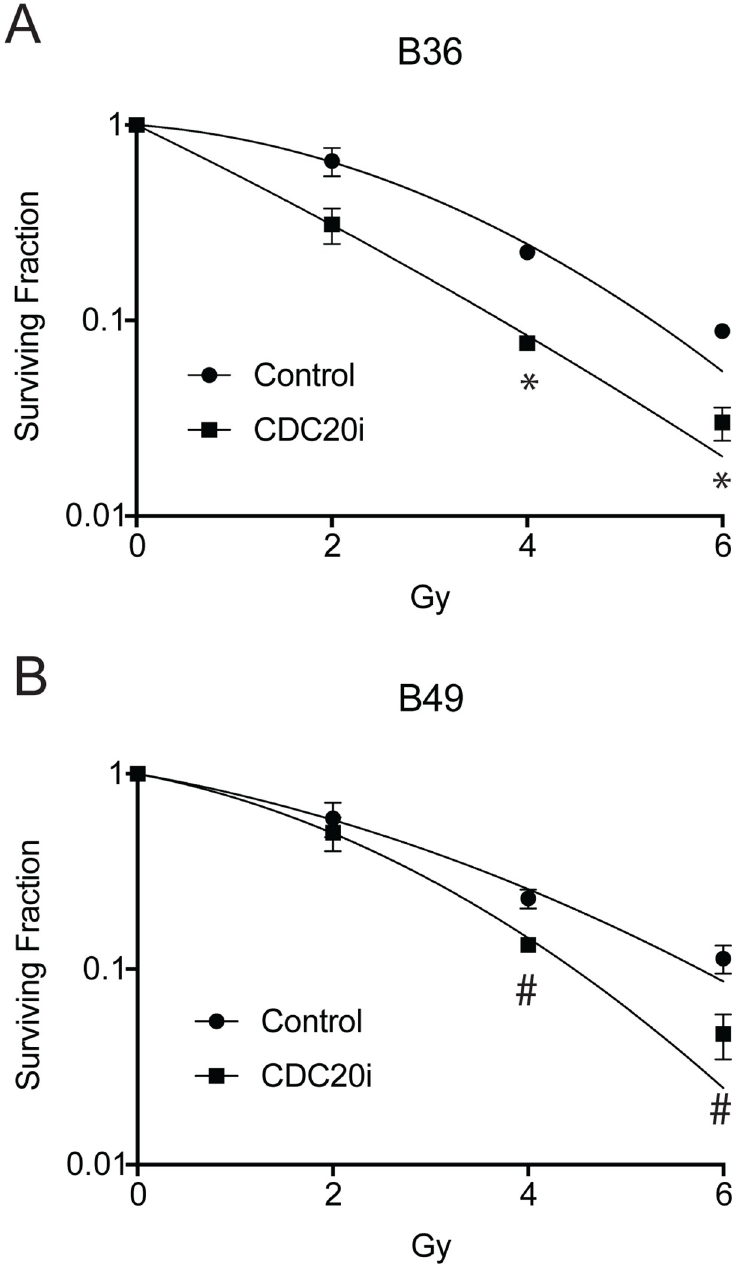
Fig 2. CDC20 inhibition sensitizes GSCs to radiation. (A and B) B36 (A) and B49 (B) GSCs transduced with lentiviruses CDC20 RNAi or control SH002 RNAi and selected with puromycin were plated seven days post- transduction at clonogenic density after puromycin selection. Ionizing radiation (IR) was performed the following day, and clonogenic survival was determined 14 days after IR by staining colonies with 0.5% cresyl violet. The number of colonies was counted to determine the surviving fraction. Data represent mean +/- SEM (unpaired t test). � P < 0.05, �� P < 0.01, ��� P <